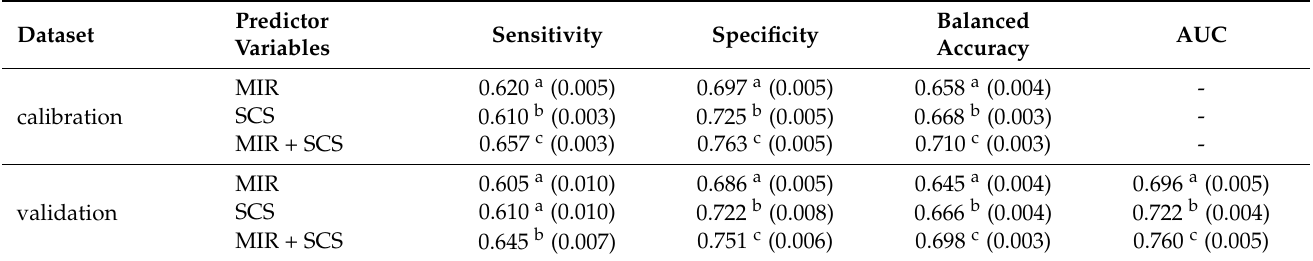
Table 3. Model performance against calibration and validation